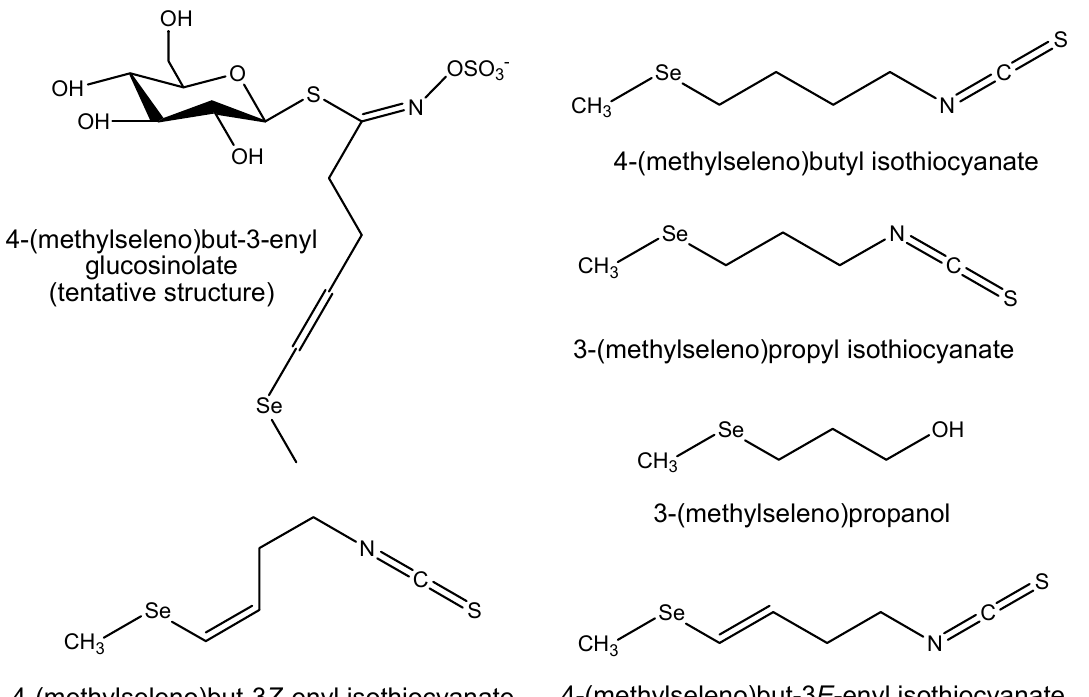
Figure 1. Selenium compounds tentatively identified in selenised Raphanus sativus seeds and sprouts. The compound eluting at 3.25 min (Figure 2), 0.65 min after the presumed 4-(methylthio)but-3 E -enyl glucosinolate, was tentatively identified as its selenised analogue 4-(methylseleno)but-3-enyl glucosinolate (4MSeB3). The presence of selenium in this compound was indicated by the complex selenium isotope pattern (Figure S1) of its pseudomolecular ion m / z − 465.9749 ([M-H] , + 0.4 mDa, calcd. for C 12 H 20 NO 9 S 2 Se,